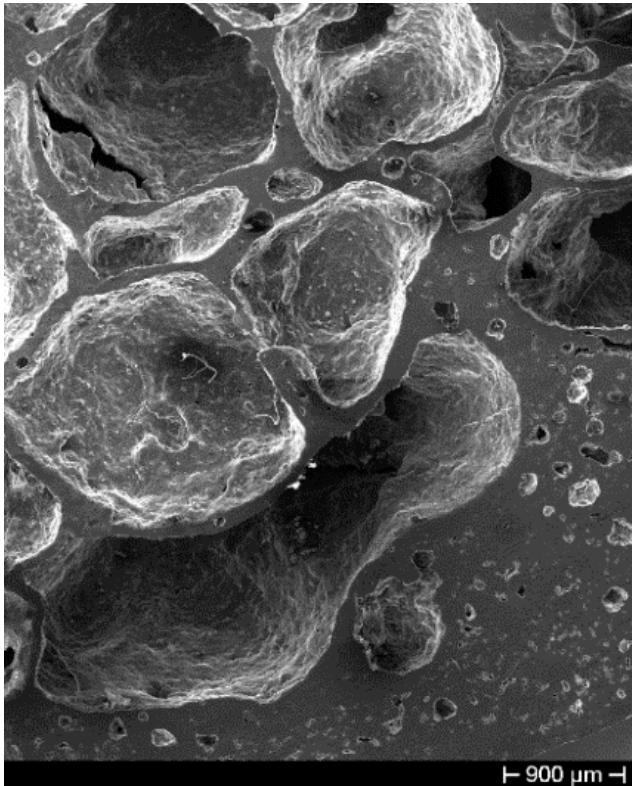
Figure 3. Scanning electron microscope (SEM) micrograph showing pore morphology. In order to analyze the alloy microstructure, specimens after grinding and polishing have been studied by using the optical microscope. Micrographs in Figure 4 show that the alloy microstructure is characterized by α grains surrounded by the eutectic phase. In correspondence with the grain boundaries, the presence of irregular particles (bright phase in Figure 4) can be noticed. These particles have been analyzed by energy dispersion spectroscopy (EDS). The analyses highlighted that some of them are Fe-based intermetallic particles as shown in the literature [31,32], while others are titanium particles deriving from the foaming process. In fact, when TiH 2 decomposes, while hydrogen gas determines the formation of cavities, Ti particles remain embedded in the alloy. Figure 5 shows in detail the two types of particles. Microhardness tests carried out on the alloy showed an average value of 77 HV 0.05 , although the grain boundary hardness reached about 92 HV 0.05 due to the presence of intermetallic particles. The mean hardness value suggests that the alloy has been subjected to natural aging (T4 temper state). The presence in the bulk alloy of shrinkage cavities, intermetallic particles, Ti particles, and cracks (Figure 4a) suggests that they could produce initiation and propagation of cracks when a load is applied. Considering that the mechanical behavior of the aluminum foam depends on the alloy microstructure and the size and distribution of cavities, it is very important to characterize cell morphology. After the acquisition of the images of the different sections of the ingots, images have been pre-processed to remove noise, then segmentation has been performed to identify the regions of interest. In this way, features such as cell size and roundness have been studied (Figure